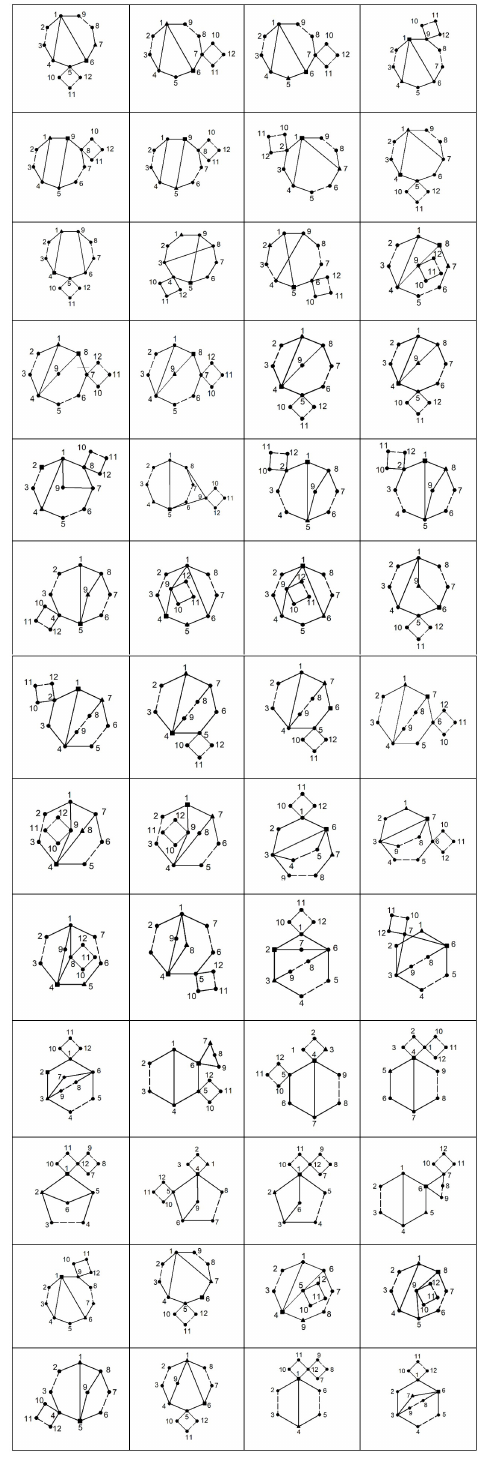
Figure A1. A total of 52 feasible schemes without